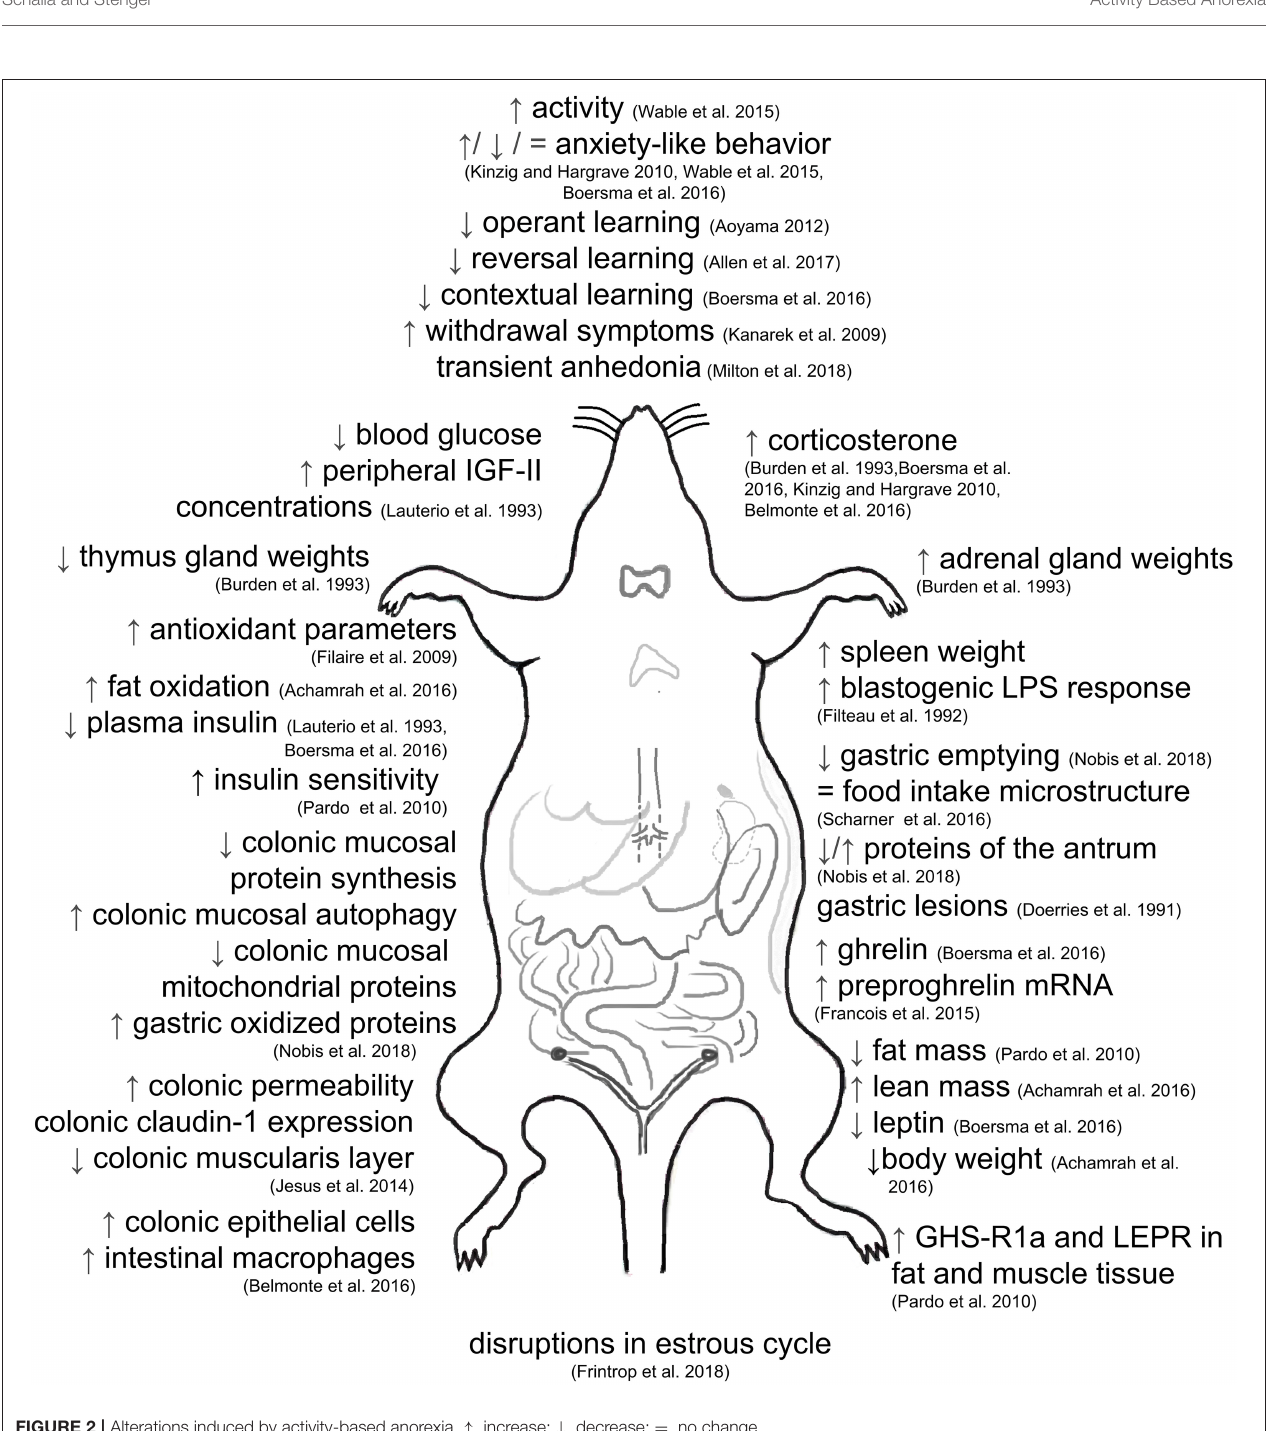
to water is necessary to induce hyperactivity and weight